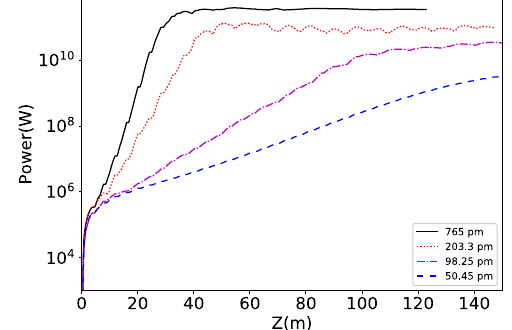
FIG. 5. Growth of photon pulse power at 7.6 Å (black line) 2 Å (red dotted), 1 Å (magenta dot-dashed) and 0.5 Å (blue dashed) for an LHeC electron beam of energy 10, 20, 30 and 40 GeV, respectively, passing through the undulator FEL line with period λ